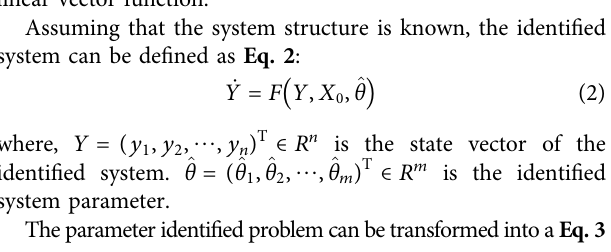
Frontiers in Physics |